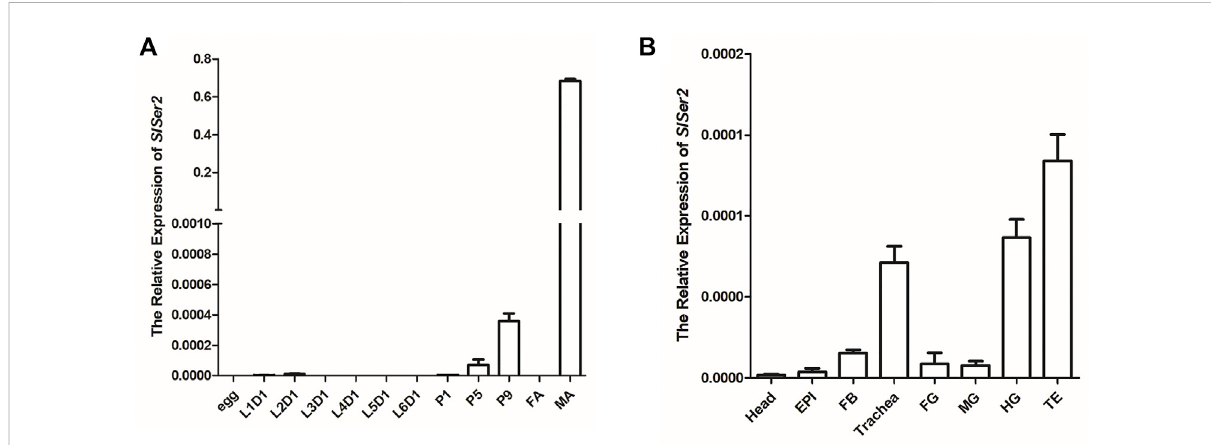
FIGURE 1 The expression patterns of SlSer2 in different developmental stages and various tissues. (A) Relative mRNA expression of SlSer2 in different developmentalstages,including egg,the fi rstdayofeachinstaroflarva (L1D1, L2D1, L3D1,L4D1, L5D1, andL6D1),pupa (P1,P5,and P9),femaleadult (FA),andmaleadult(MA). (B) RelativemRNAexpressionof SlSer2 intheeightreproductivetissuesatthethirddayofthe fi fthinstarlarval(L5D3)stage, including head, epidermis (EPI), fat body (FB), trachea, foregut (FG), midgut (MG), hindgut (HG), and testis